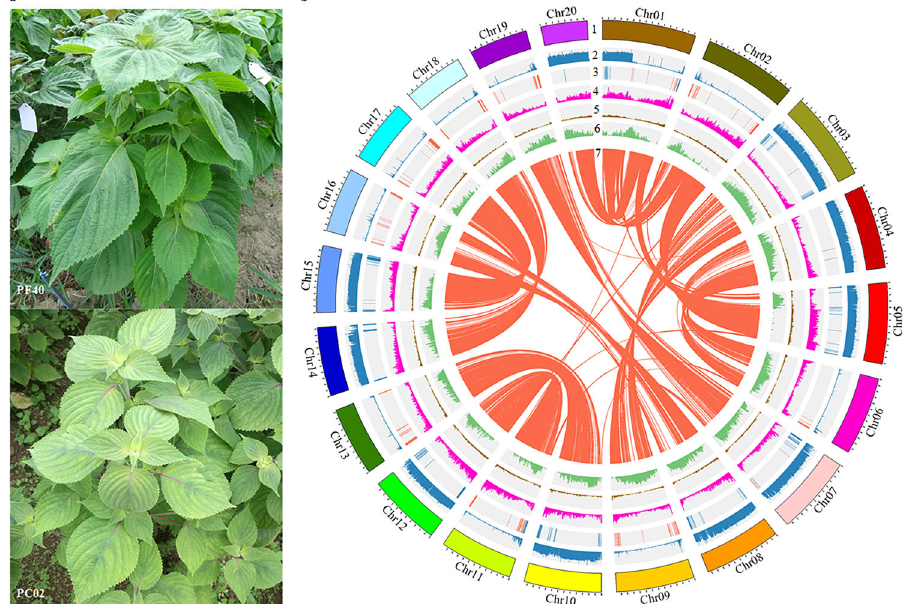
Fig. 1 Genome of the allotetraploid P. frutescens . a Images of mature plants of the allotetraploid PF40 and the diploid PC02 used for de novo assemblies. b Mapped features of the allotetraploid genome including (1) chromosomes arbitrarily numbered in descending order of their assembled lengths, (2) mapping depth distribution by PC02 in 10-kb windows, (3) distribution of 527 pairs of HE genes on PFA (as blue lines) and PFB (red lines) subgenomes, (4) density of predicted genes in 500-kb windows (with values 0 – 67), (5) density of predicted pseudogenes in 500-kb windows (0 – 67), (6) percentage of repeats in 500-kb windows (0.5 – 1.0), and (7) PFA-PFB synteny linked by red lines ( n = 15,170). Ticks on the outer circumference represent 5-Mb units of chromosome